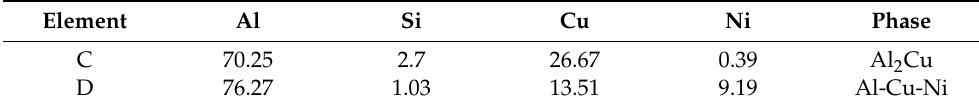
Figure 2. Microstructure and phase analysis of as cast Al-13Si-5Cu-2Ni alloy: ( a ) low magnification microstructure, ( b ) local magnification in figure ( a ), ( c ) XRD pattern, ( d ) C compositional analysis by EDS, and ( e ) D compositional analysis by EDS. Table 2. Element content data of each phases